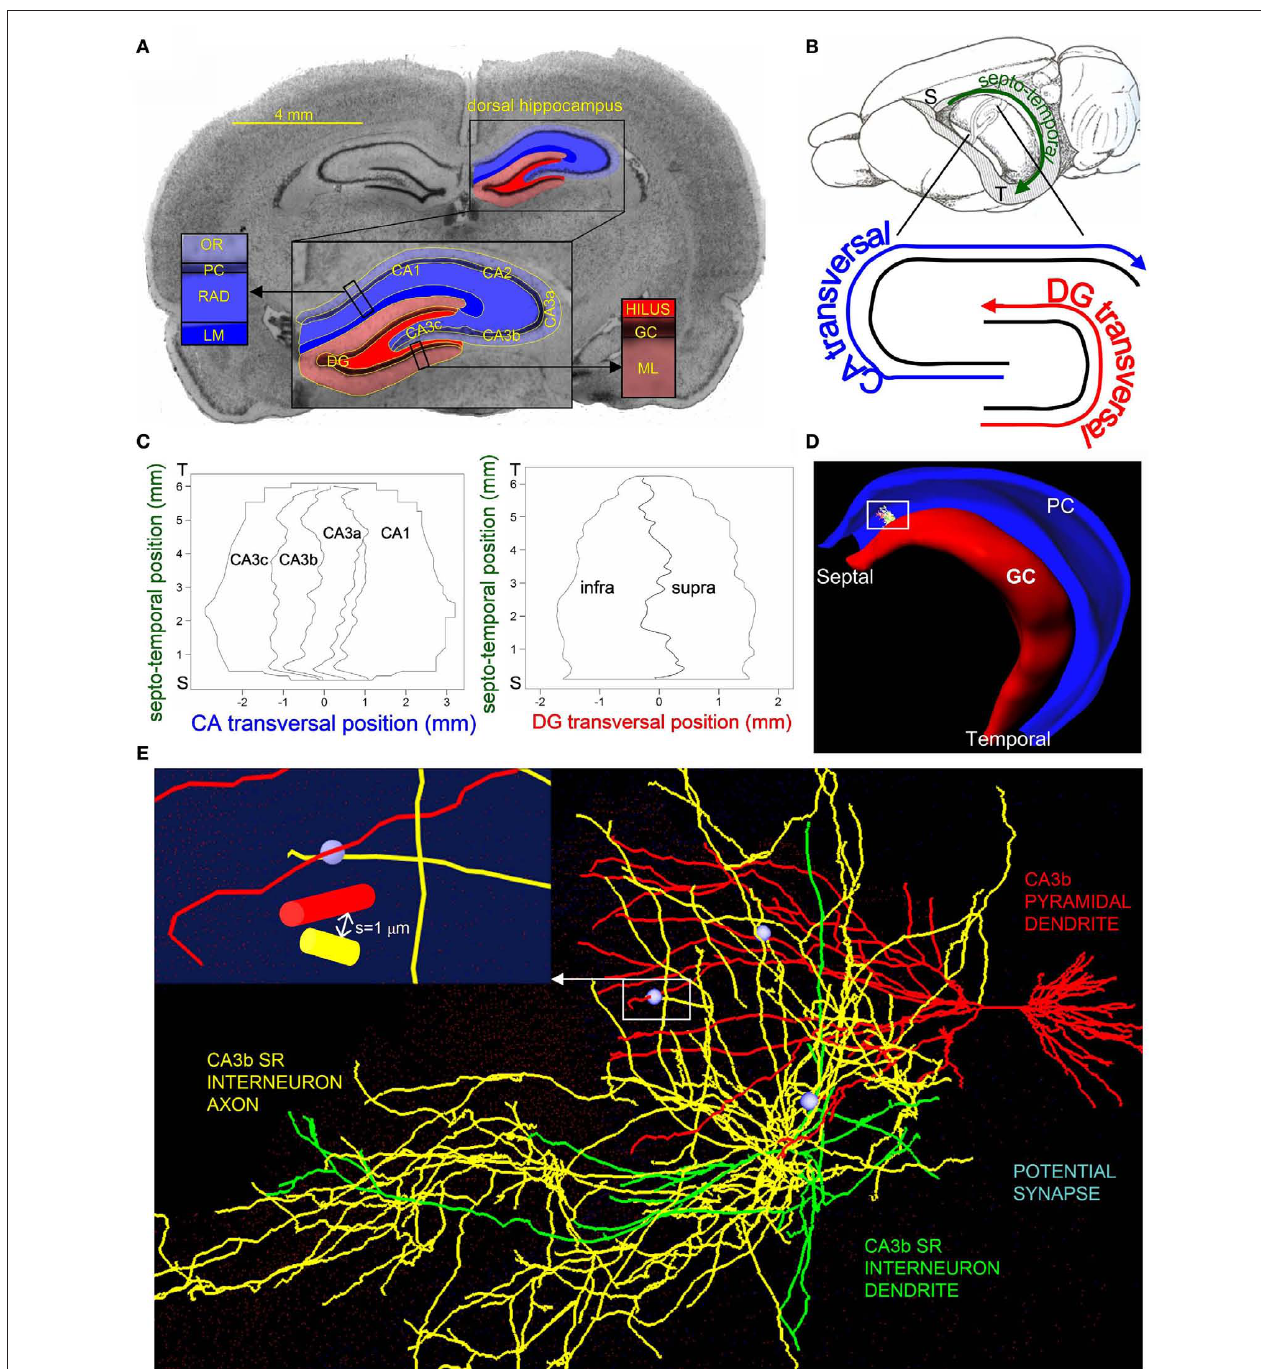
permission from Elsevier. (C) Maps marking the CA and DG sub-region borders with respect to the septo-temporal and transversal axes. (D) Representation of the DG (red) and CA (blue) principal layers of the hippocampus 3D reconstruction, with an embedded CA3b SR interneuron and a CA3b pyramidal cell dendritic tree. (e) Enlarged view of the CA3b SR interneuron (axon: yellow, dendrite: green) and the CA3b pyramidal cell (red), illustrating three potential synapses (light blue). Inset shows a further zoom-in on one of the potential synapses, identifying a location where the interneuron axon is within 1 μm of the CA3b pyramidal